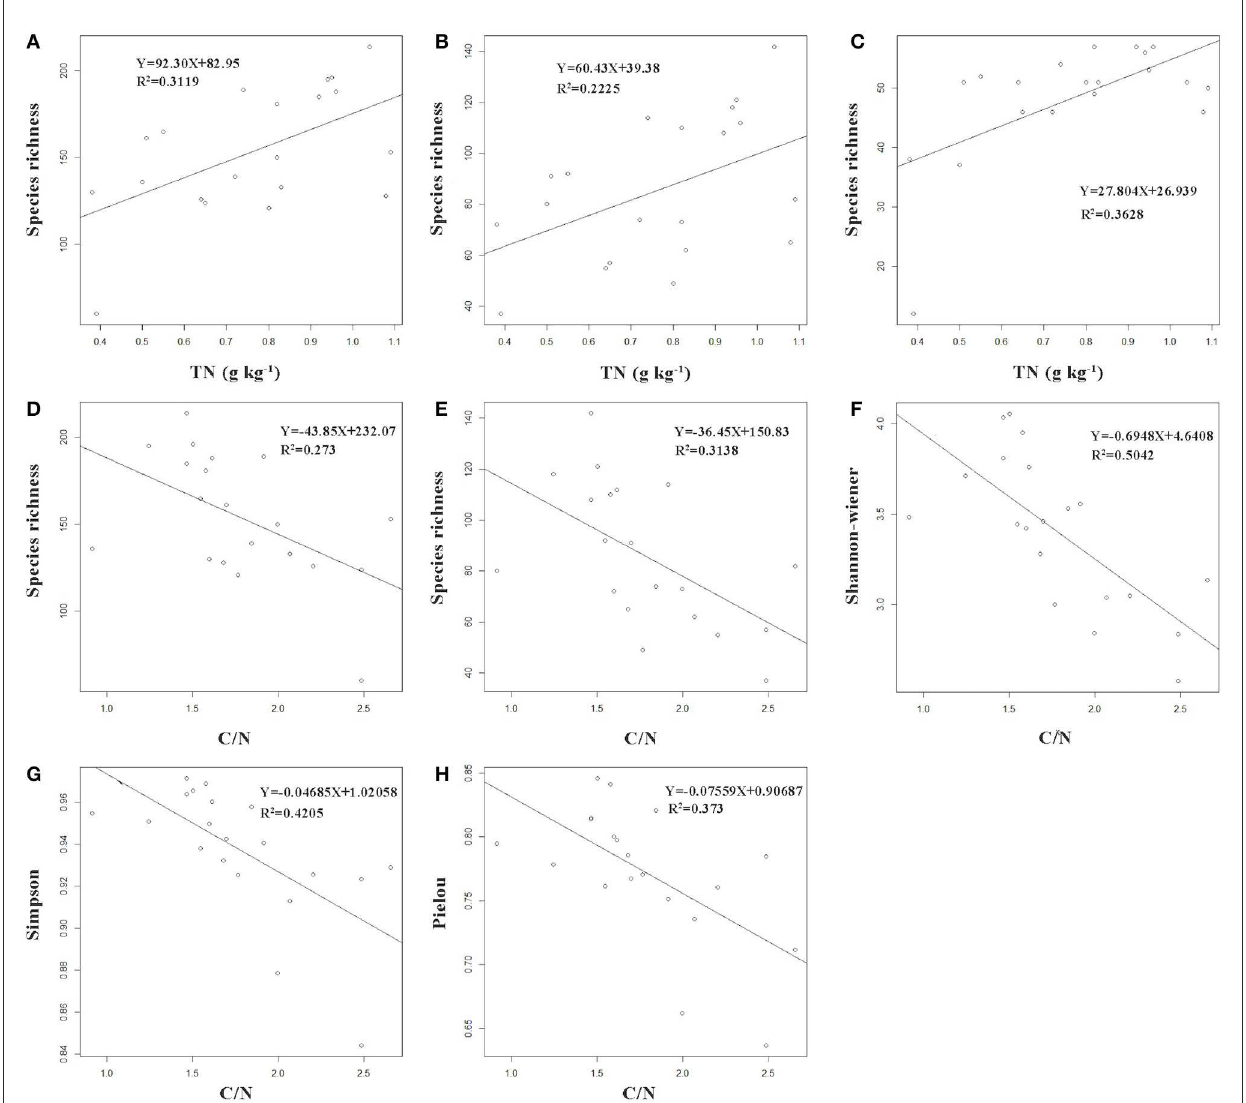
FIGURE4 The relationship between diversity indices of AMF and soil physicochemical properties. Y and R 2 represent the diversity indices of AMF and the coefficient of determination for this regression equation, respectively. Diagrams of all species of AMF: (A, D) ; Diagrams of rare species of AMF: (B, E–H) ; Diagrams of common species of AMF: (C) ; TN, soil nitrogen; C/N, carbon/nitrogen